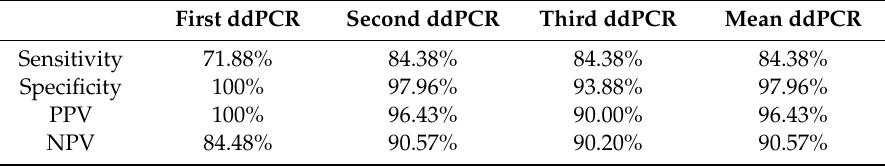
Table 3. Diagnostic value of repeated measurement of KRAS G12 / 13 mutation by